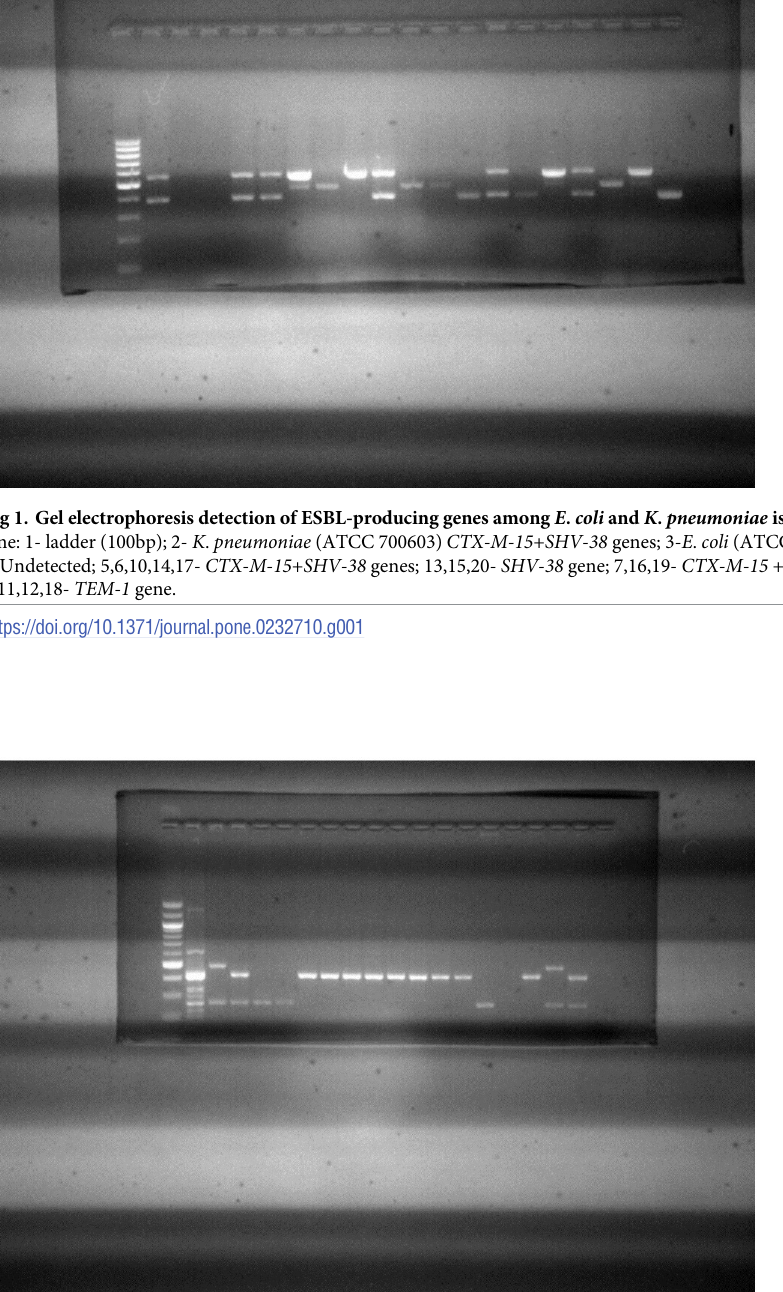
PLOS ONE | https://doi.org/10.1371/journal.pone.0232710 May 8,